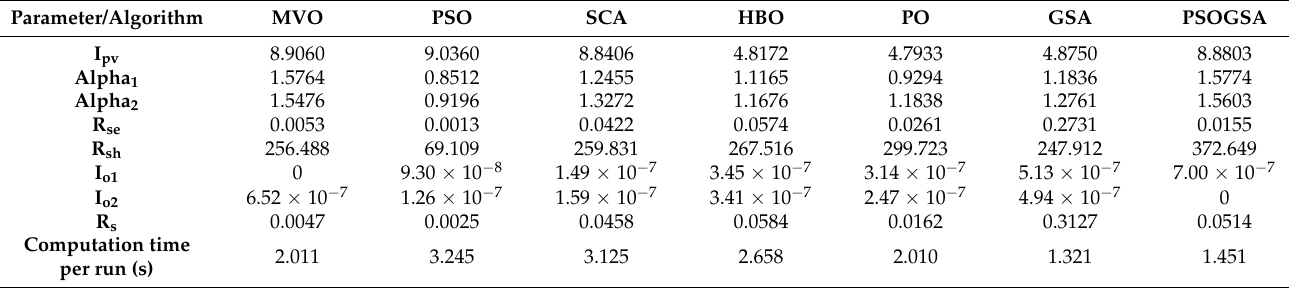
Table 14. Results of parameter estimation of the MDDM for the polycrystalline PV